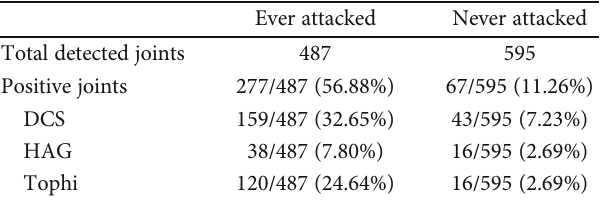
(b) US fi ndings and clinical attacks in the joints of gouty patients